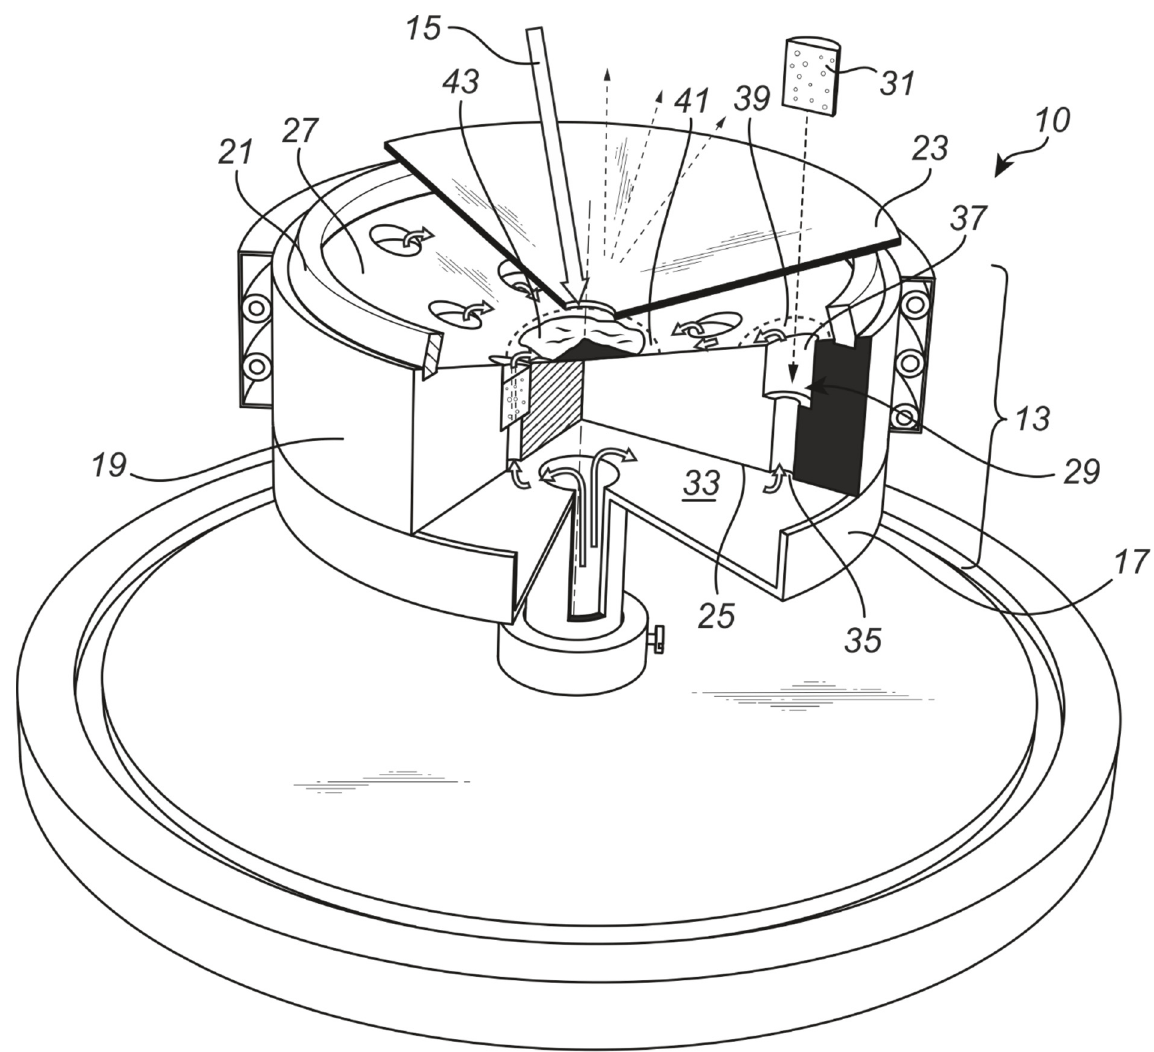
Figure 1. An optimised meson source mounted on a 100 mm diameter flange. This figure can be found on the web as part of the patent application WO2018093312 [36]. No. 31 is a catalyst sample which forms the ultra-dense hydrogen H(0). No. 15 is the laser beam. See the text for further information. The collectors and coils which observe the mesons and muons are mounted in the vertical direction above the meson source.